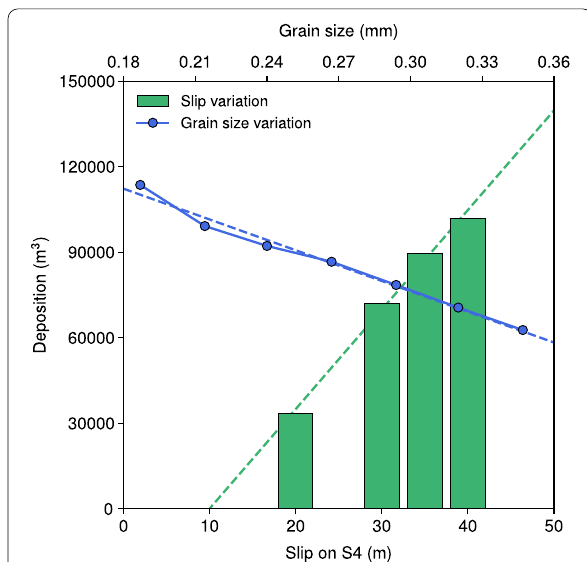
Fig. 12 Comparison of changes in the deposition volume with variations in slip on S4 (with fixed slip of 10 m on S9) and grain size. Dashed lines indicate linear approximations of the data shown in the same